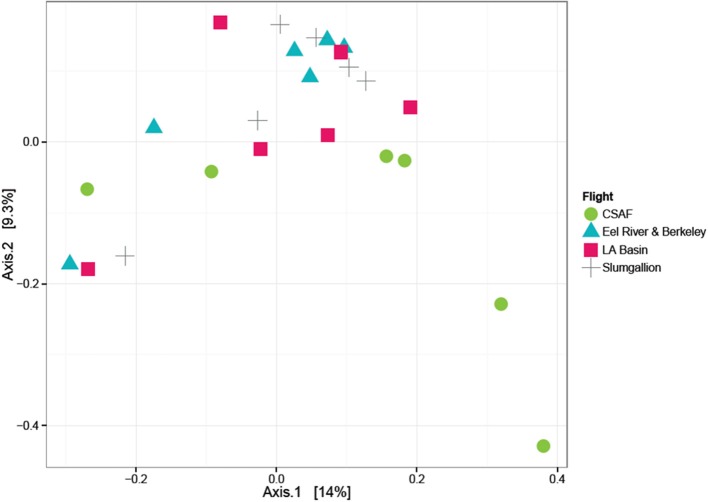
Unweighted ordination plot based on OTU presence/absence showing that samples did not cluster by flight. The first two ordination axes accounted for 23.2% of sample variation.